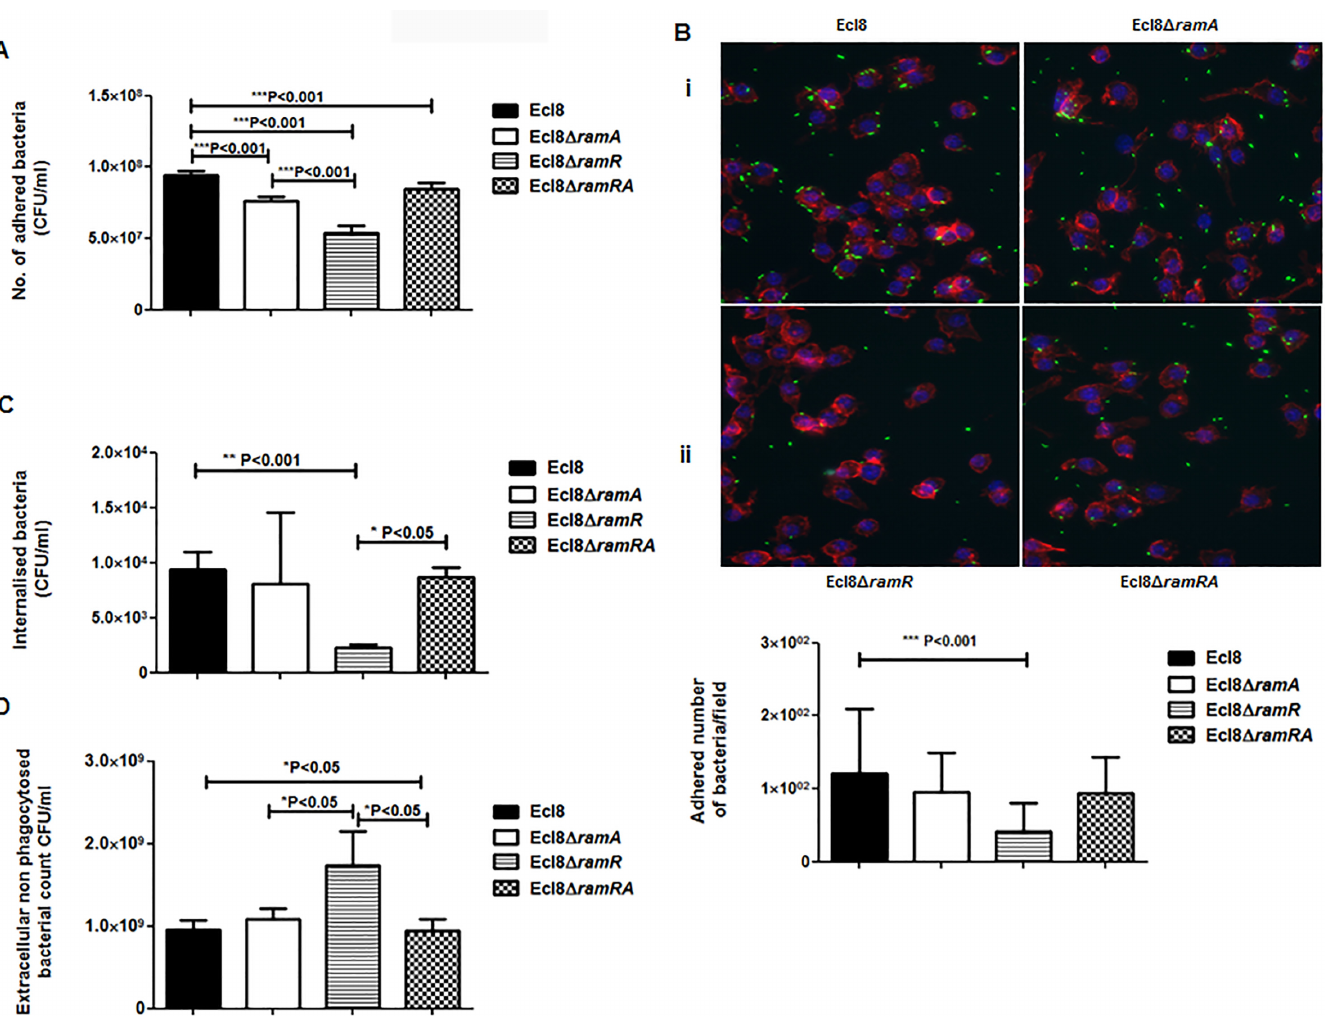
Fig 7. A: Attachment of K . pneumoniae Ecl8, Ecl8 Δ ramA , Ecl8 Δ ramR or Ecl8 Δ ram RA to murine macrophage RAW 264.7 cell line. One-way ANOVA analyses were performed to demonstrate statistical significance. B: Microscopy to assess attachment to RAW 264.7 cell line. (i) Infection of the RAW264.7 cell line was carried out with K . pneumoniae Ecl8 (WT), Ecl8 Δ ramA , Ecl8 Δ ramR or Ecl8 Δ ramRA transformed with plasmid pRSMgfp. MOI was 1:100 and infections were carried out for 2 hrs. The actin cytoskeletonwas stained with Acti stain 555 phalloidin (red) and host cell nuclei were stainedwith DAPI (blue). Images are representative of 80 fields. (ii) Graph representating mean values are derivedfrom 3 independent experiments. One-way ANOVA analyses (P < 0.001) were performedto demonstrate statisticalsignificance. C: Internalisation of K . pneumoniae Ecl8, Ecl8 Δ ramA , Ecl8 Δ ramR or Ecl8 Δ ramRA by RAW 264.7 cells. Bacterial internalisation was assessed by the gentamicin protection assay. One-way ANOVA analyses were performedto demonstrate statistical significance. D: Enumeration of the extracellular non-phagocytosed K . pneumoniae Ecl8, Ecl8 Δ ramA , Ecl8 Δ ramR or Ecl8 Δ ramRA . One-way ANOVA analyses were performedto demonstrate statisticalsignificance.